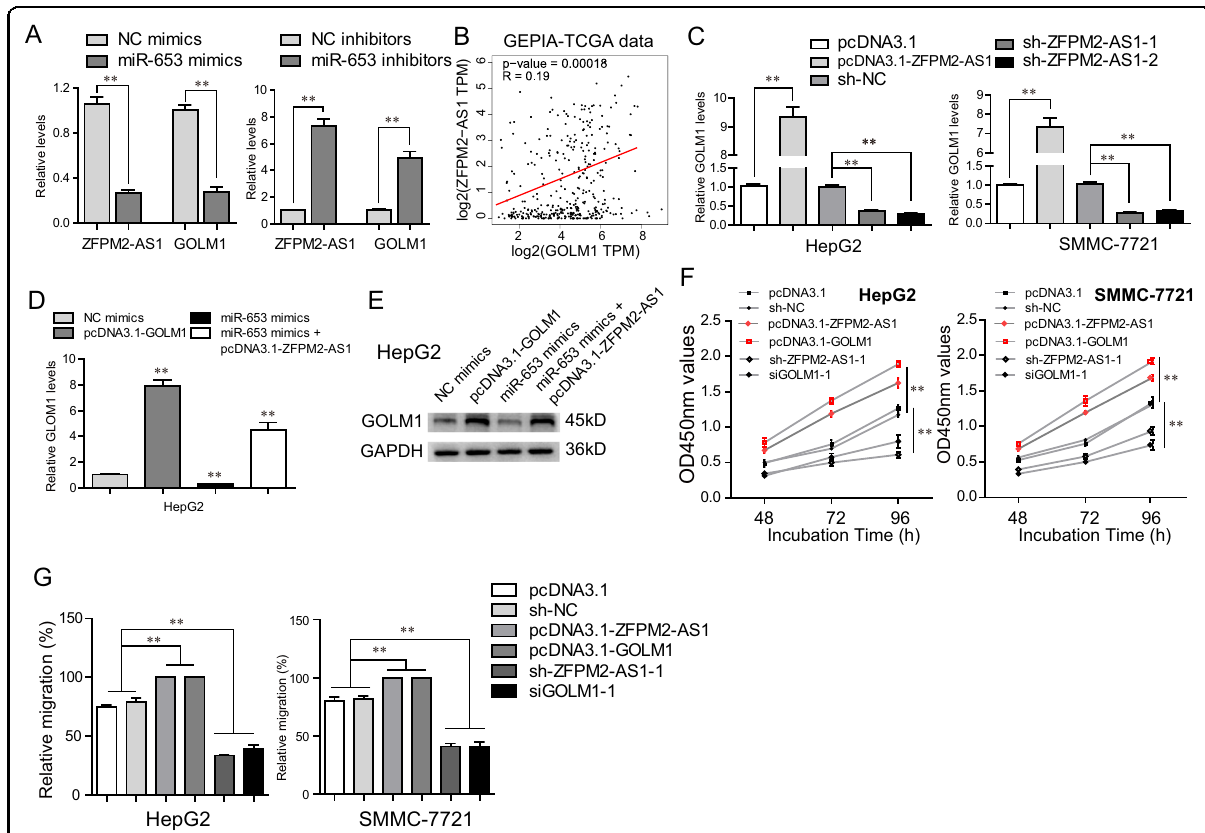
Fig. 8 ZFPM2-AS1 modulated HCC cell malignancies via miR-653/GOLM1 axis in HCC cells. A ZFPM2-AS1 and GOLM1 expressing levels in HCC cells were assessed by qPCR analyses when their miR-653 was overexpressed or knocked down. B GEPIA algorithm analyzed the expressing correlation between ZFPM2-AS1 and GOLM1 in HCC using TCGA data. C GOLM1 levels in HCC cells were examined by qPCR analyses when their ZFPM2-AS1 was overexpressed or knocked down, and vice versa. D , E RT-PCR and western blot analyses measured GOLM1 protein levels in HepG2 cells. F CCK-8 examined the HCC cellular proliferation under various treatment. G Wound-healing assays detected the changes of migration capacities of HCC cells after various treatment. Data are presented as the mean ± SD from three independent experiments. * P < 0.05, ** P <